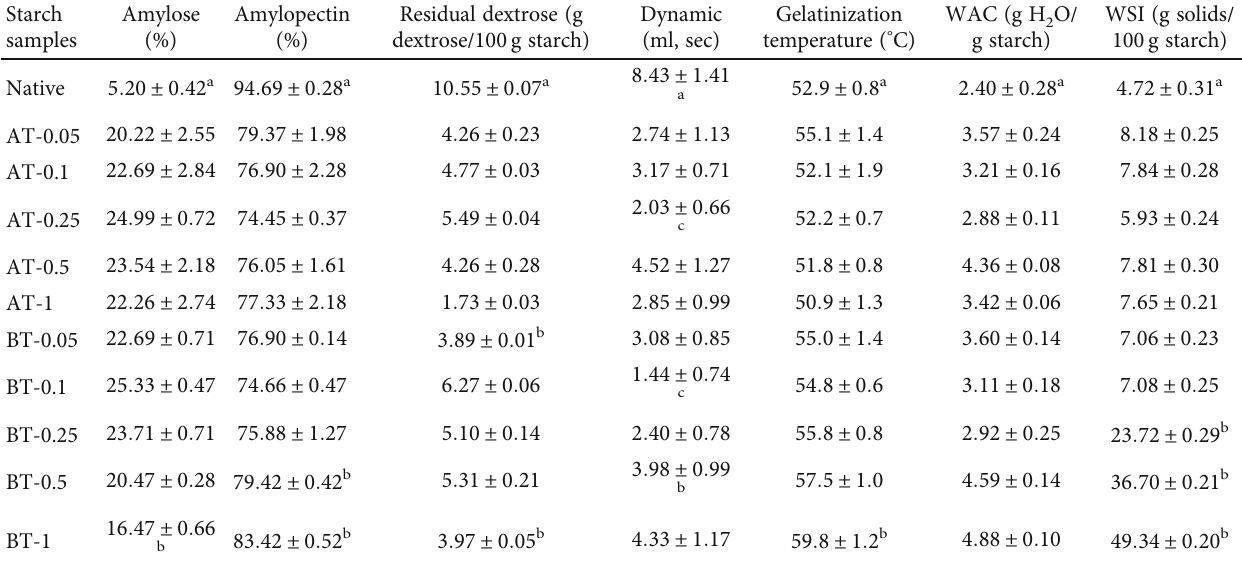
Table 2: Physical-chemical parameters and functional properties of native and fermented modi fi ed cassava starches. Starch Amylose Amylopectin samples